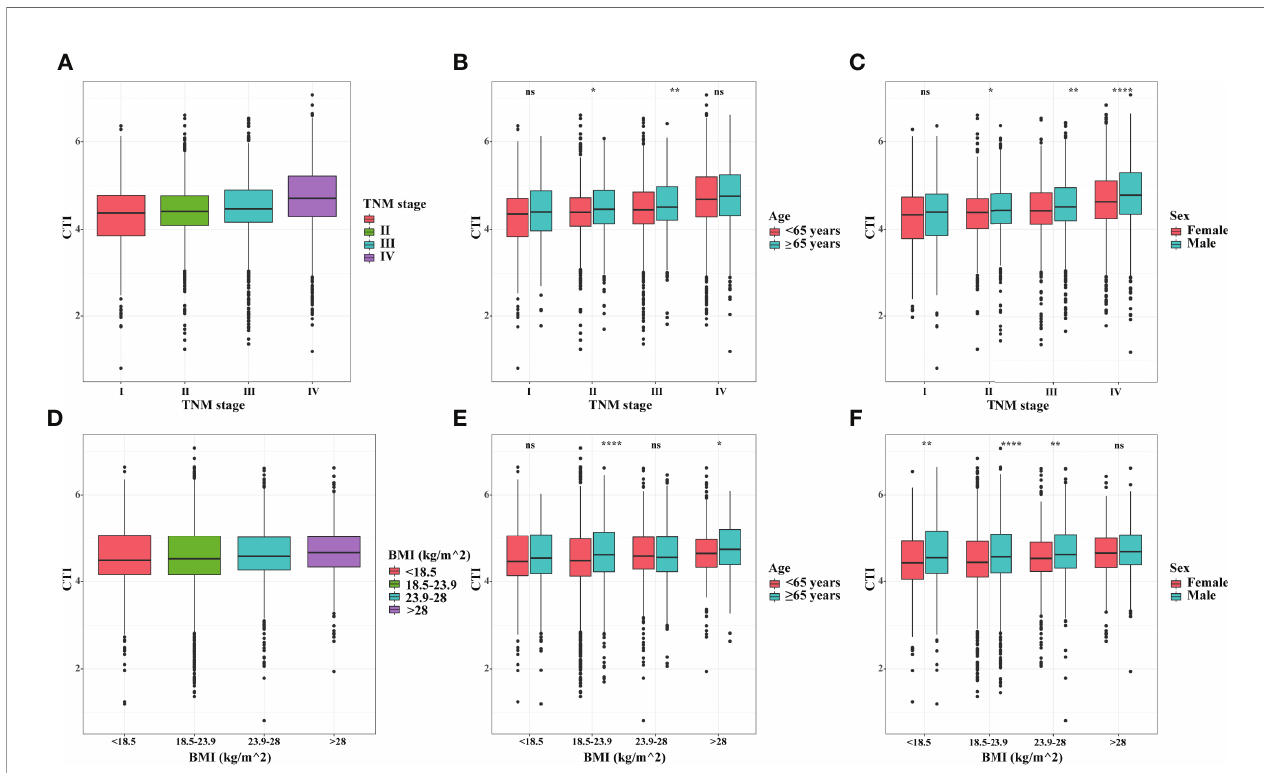
FIGURE 1 | The distribution of CTI in different groups. (A) CTI in TNM stage groups; (B) CTI in TNM stage groups strati fi ed by age; (C) CTI in TNM stage groups strati fi ed by sex; (D) CTI in BMI groups; (E) CTI in BMI groups strati fi ed by age; (F) CTI in BMI groups strati fi ed by sex. CTI, C-reactive protein-triglyceride glucose